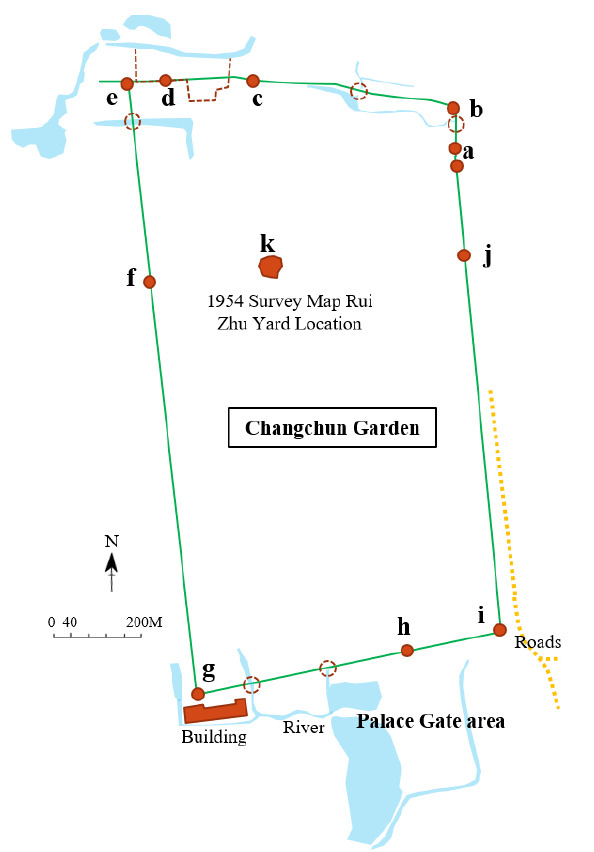
Figure5. Full map of the boundaries and layout of the Changchun Garden.